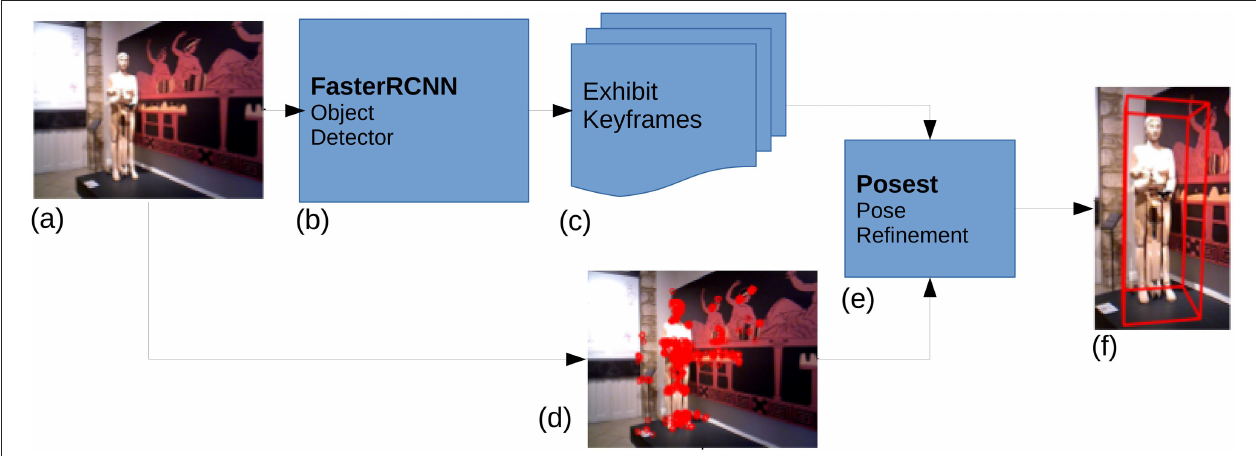
FIGURE 1 | The CNN-Posest+ pipeline: (a) Exhibit input image from the visitor’s mobile device, (b) CNN based object detector finds the 2D bbox and id of the exhibit, (c) Exhibit keyframes are selected based on exhibit id, (d) images features are computed, (e) Posest Pose estimation step using (c,d) , (f) Exhibit 3D pose is returned to the mobile device.